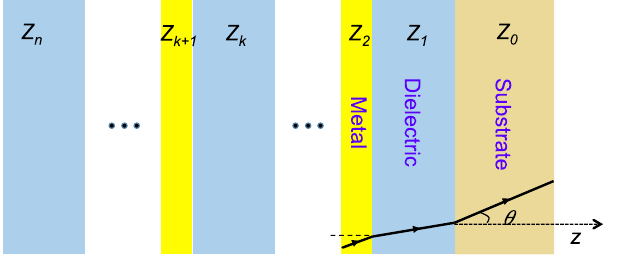
Figure 1. Multilayer structure for perfect absorbers. Z k is the characteristic impedance of the layer